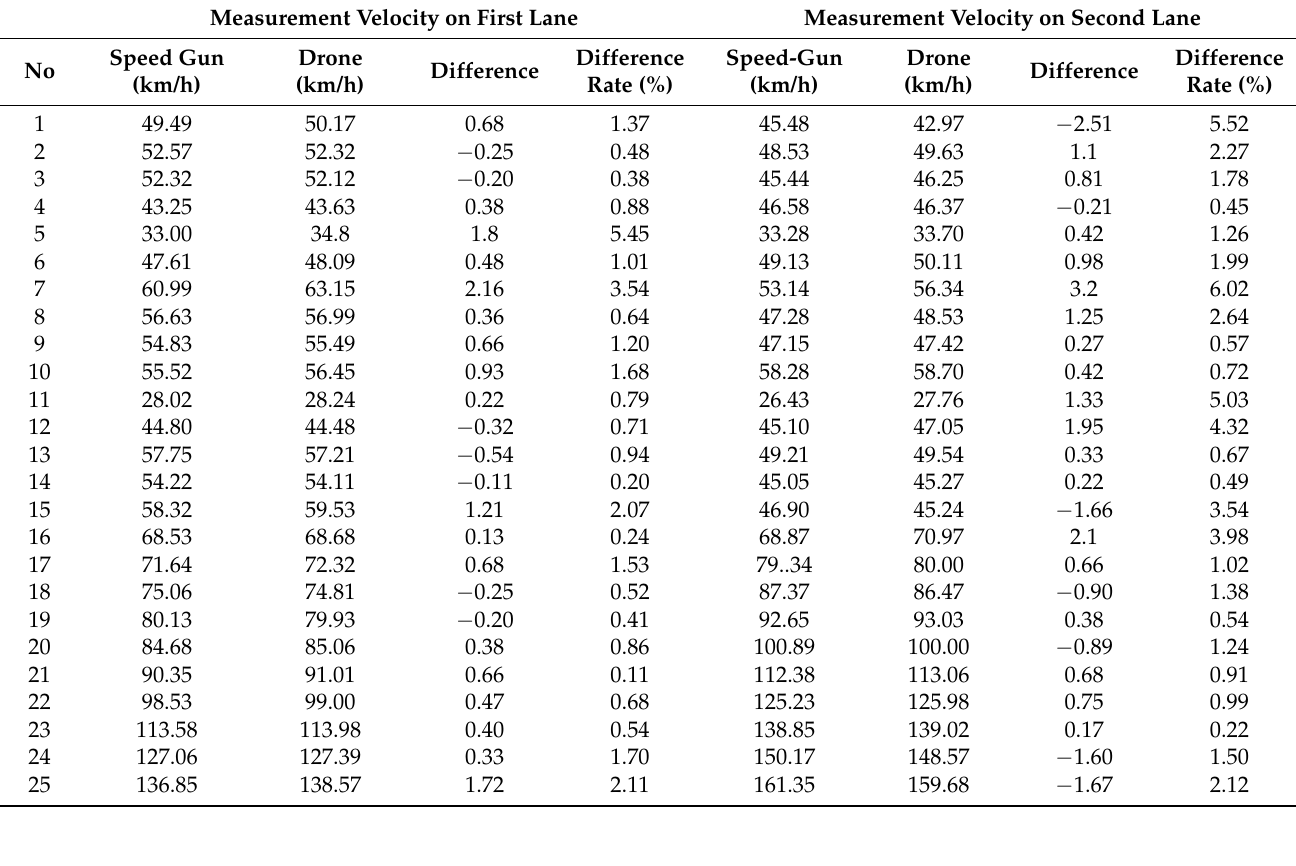
wind speed of 12.1 m/s when the distance is 1 m.